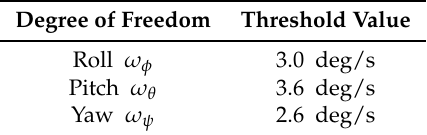
Table 1. Threshold values for rotational